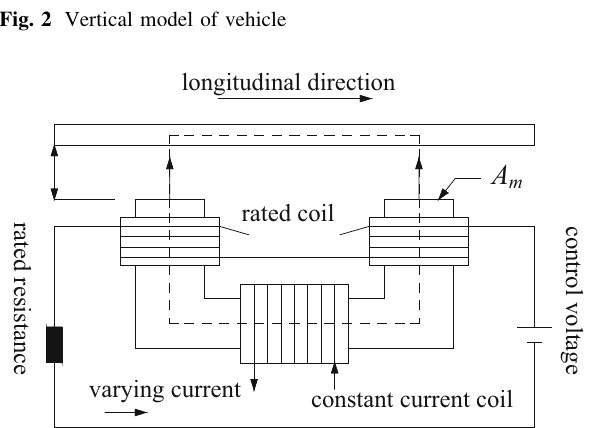
Fig. 3 Electromagnet system